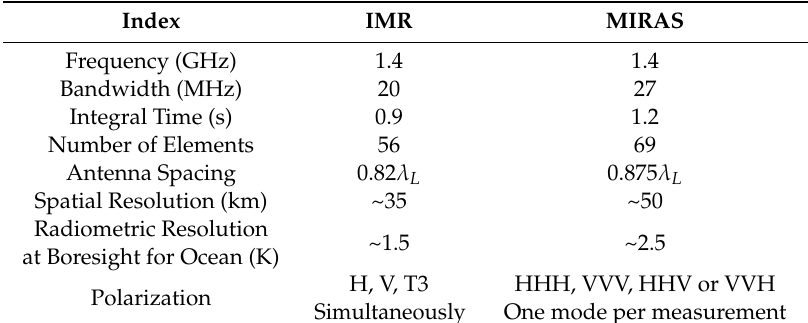
Table 1. Comparison between IMR and Soil Moisture Ocean Salinity (SMOS) mission’s Microwave Imaging Radiometer with Aperture Synthesis (MIRAS). Figure 2. Arrangement of IMR’s antenna array with the spacing of antenna elements normalized to wave length of L-band ( 𝜆 (cid:3013) ), and the three arms in the Y-shaped array are label as Arm 1, 2 and 3, respectively. Two different array orientations are named as A and B, and the flight direction are indicated as black arrows.